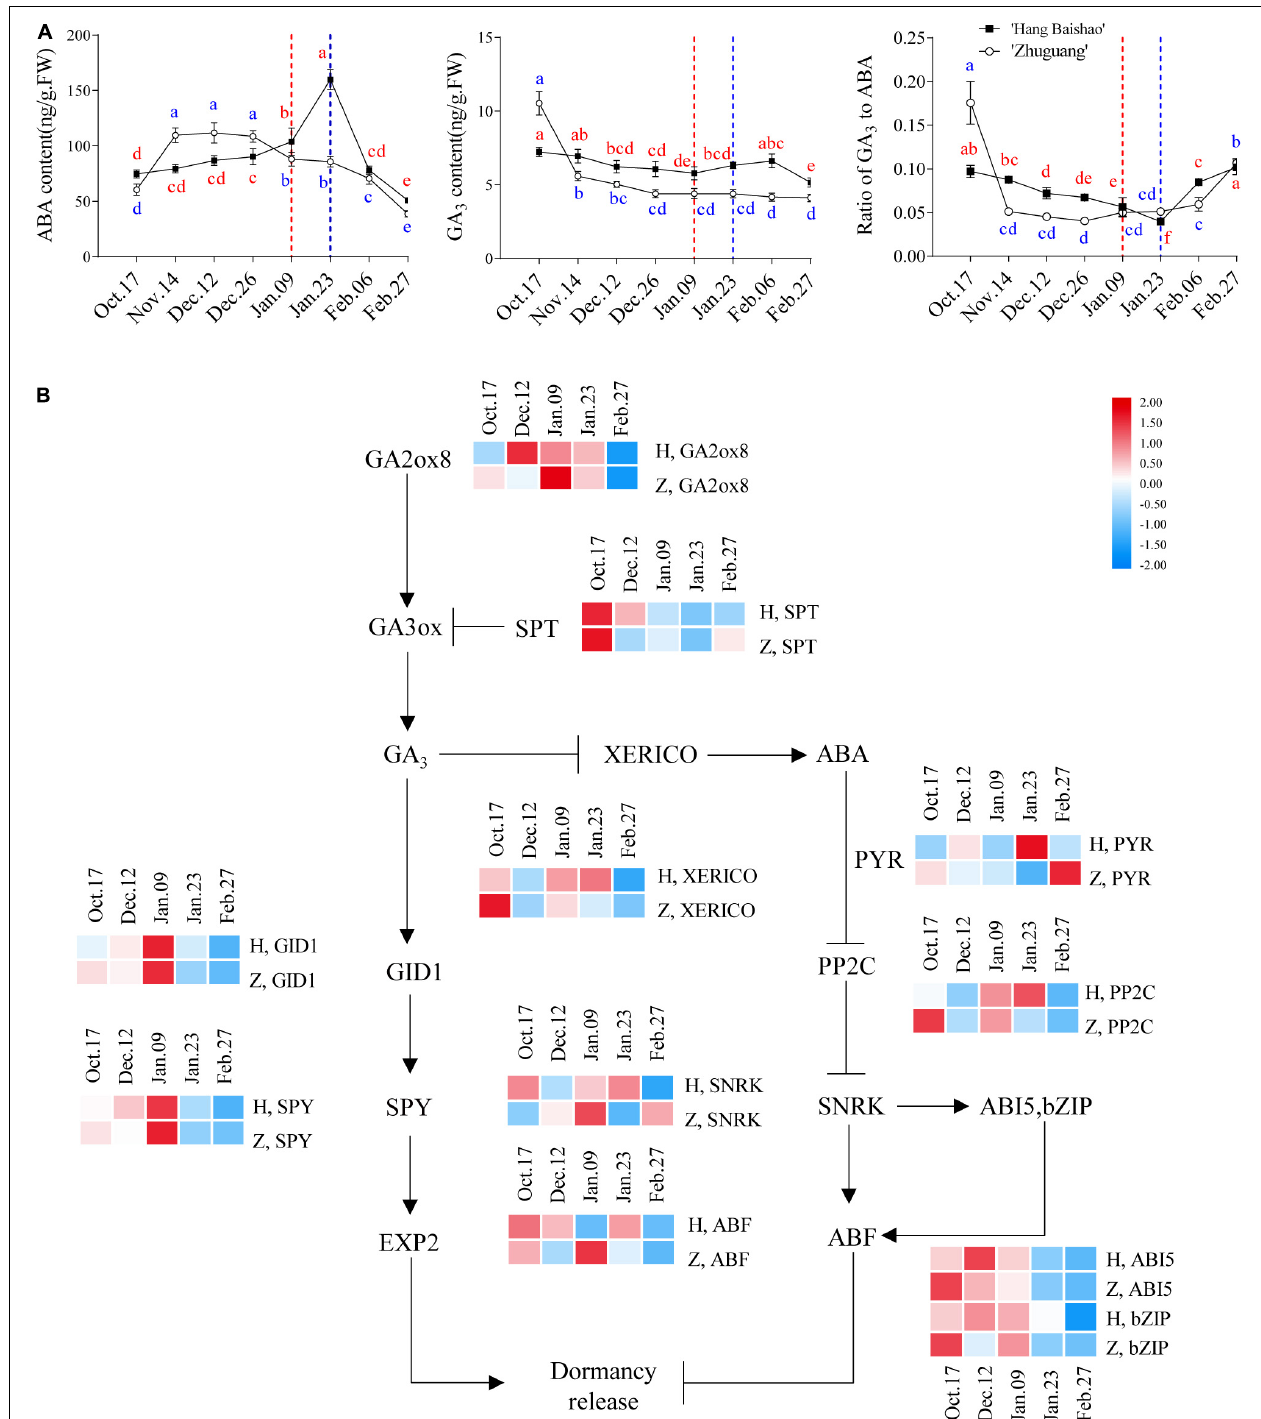
FIGURE 4 | Expression patterns of genes involved in the GA 3 and ABA signal transduction pathway and changes in concentrations of GA 3 and ABA in ‘Hang Baishao’ and ‘Zhuguang’ during bud dormancy. (A) Concentrations of ABA and GA 3 and ratio of GA 3 to ABA in ‘Hang Baishao’ and ‘Zhuguang’ during bud dormancy. (B) Expression patterns of genes involved in the GA 3 and ABA signal transduction pathway. The dashed red line indicates the bud endodormancy release date of low CR ‘Hang Baishao,’ and the dashed blue line indicates the bud endodormancy release date of high-CR ‘Zhuguang.’ H represents ‘Hang Baishao’; Z represents ‘Zhuguang.’ Error bars represent standard deviation from three biological replicates and different letters indicate significant differences ( P < 0.05). Differences were compared among different move dates for each cultivar.